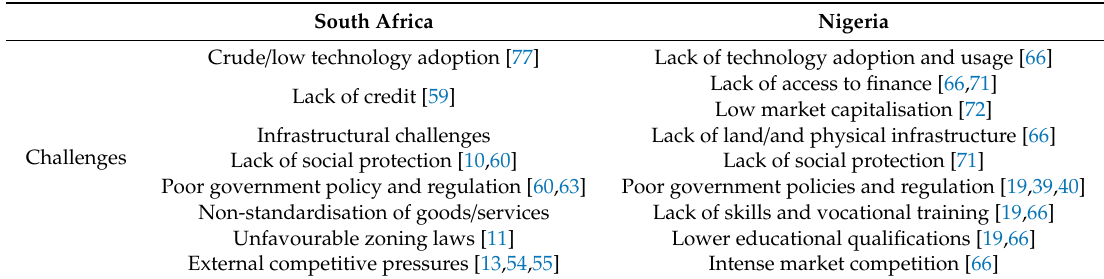
Table 12. Challenges of the informal sector in South Africa and